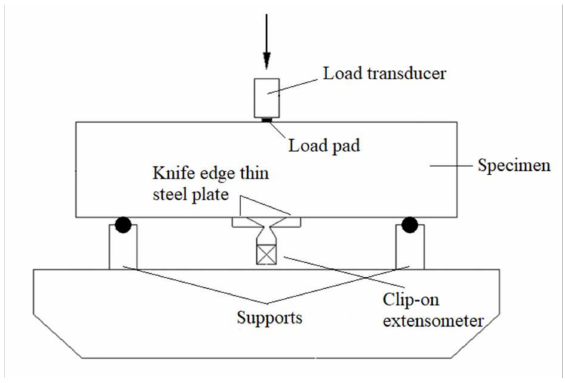
Figure 4. Schematic diagram of the fracture properties test